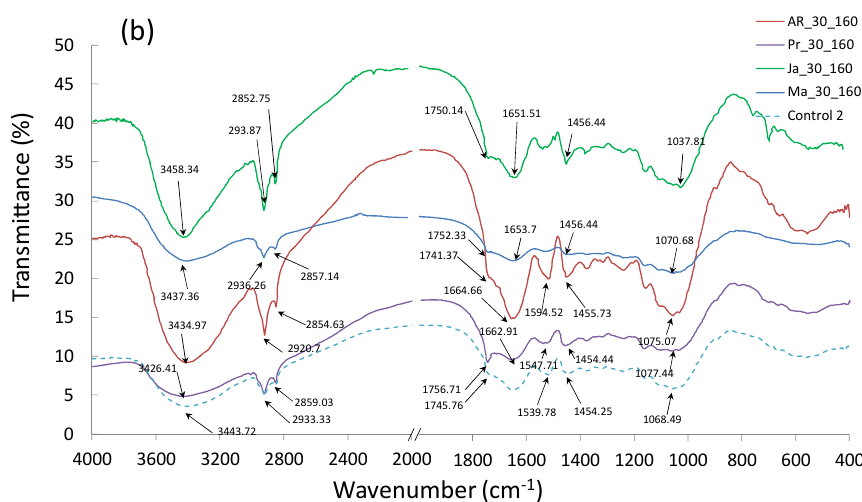
Figure 8. Fourier Transform Infrared Spectroscopy (FTIR): ( a ) tests of biocomposites containing 30 wt% of pomace, produced at process temperature of 130 °C, ( b ) tests of biocomposites containing 30 wt% of pomace, produced at process temperature of 160 °C .